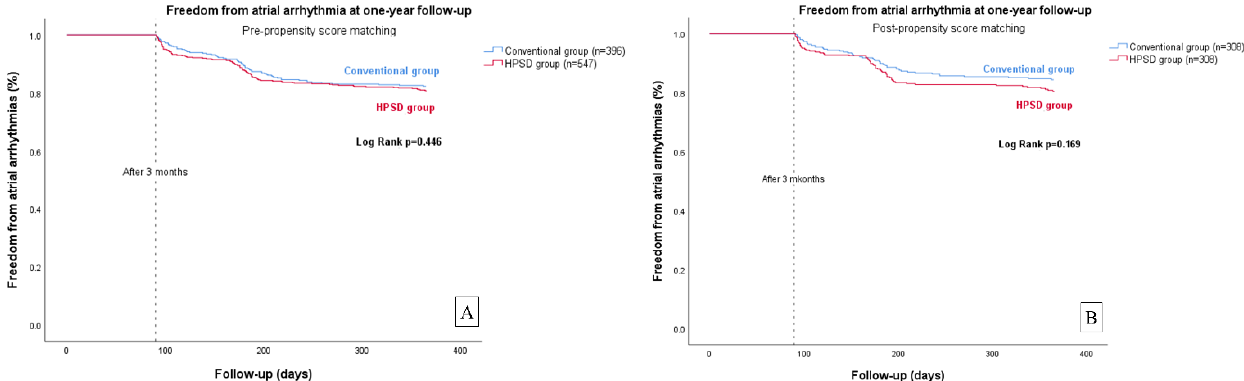
Table 5. Baseline characteristics of patients undergoing repeat procedures.